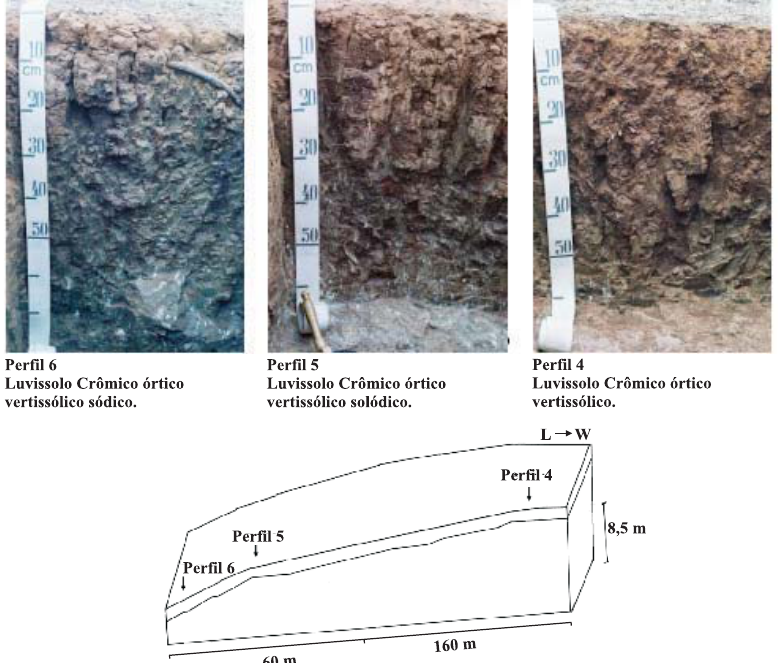
Figura 2. Representação esquemática da localização dos perfis ao longo da sequência e fotografias dos perfis de solo da Topossequência